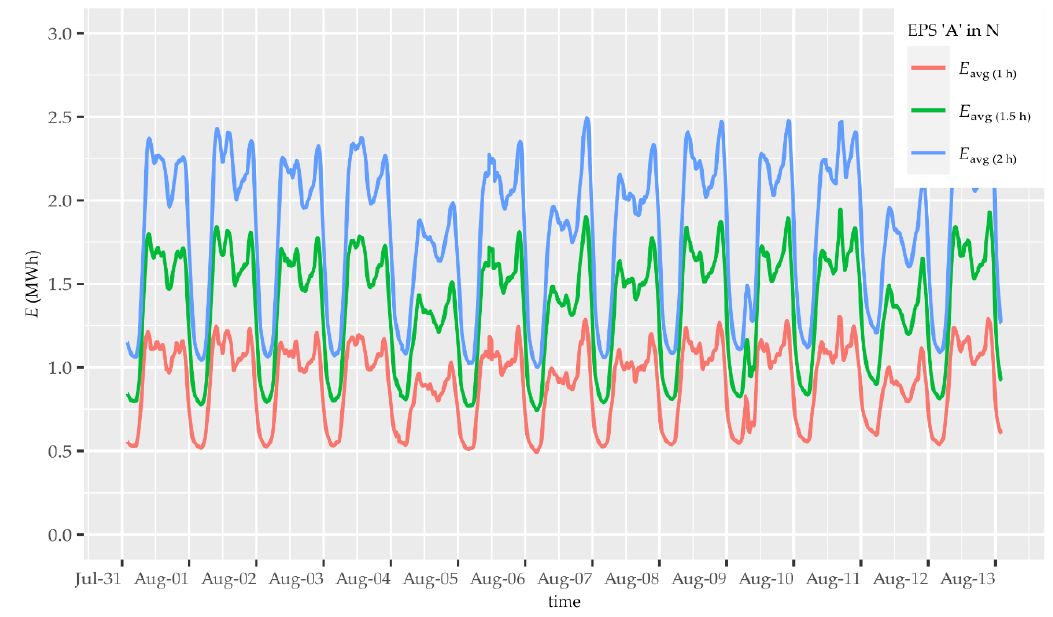
Figure 8. The 2-week period of energy flow E EPS”A” consumption at EPS “A” in the normal operating condition N without “IP”.